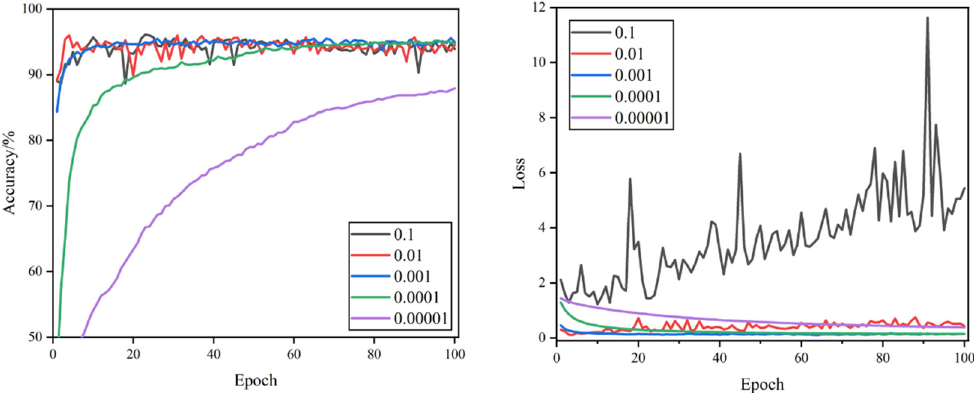
Figure 7. Validation accuracy and loss curves of different learning rates when dropout = 0.5.